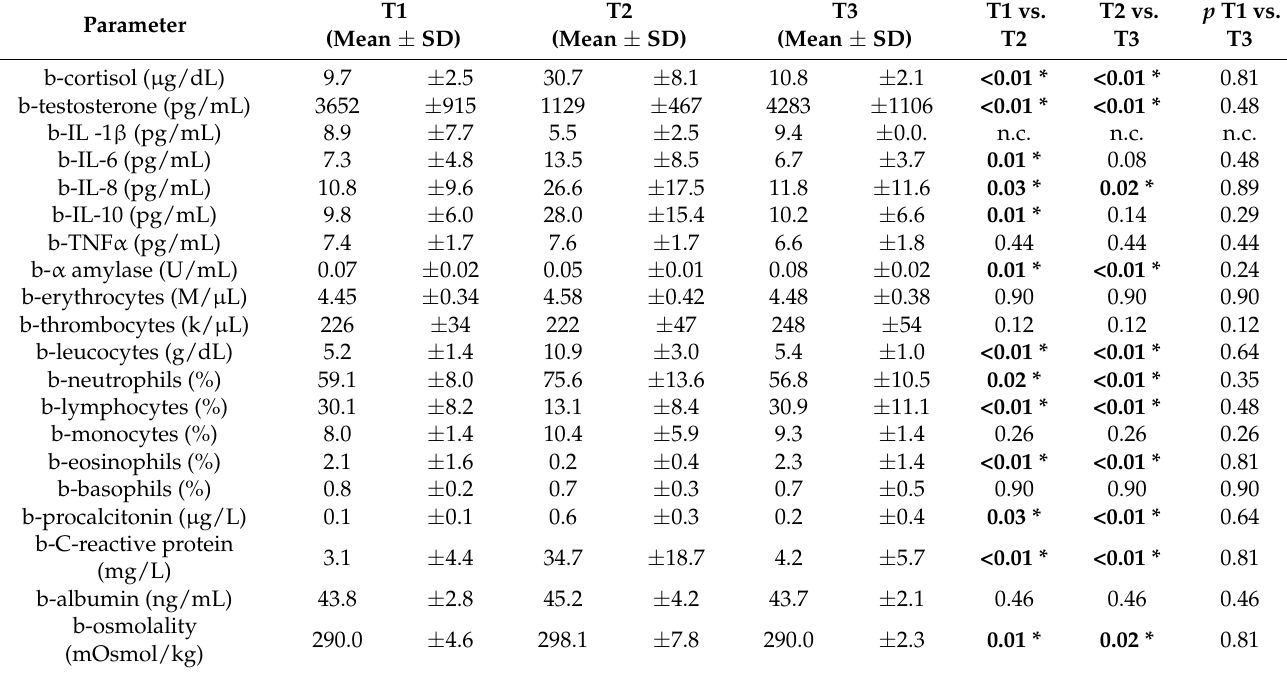
Table 3. Blood parameters at baseline (T1), shortly after the ultramarathon (T2), and after recovery (T3) and p -values for differences between time points. The p -values indicate the longitudinal differences calculated by Friedman test and, in case of significant differences, by Dunn’s pairwise post hoc test. Bold values and an asterisk mark the significant differences ( p <